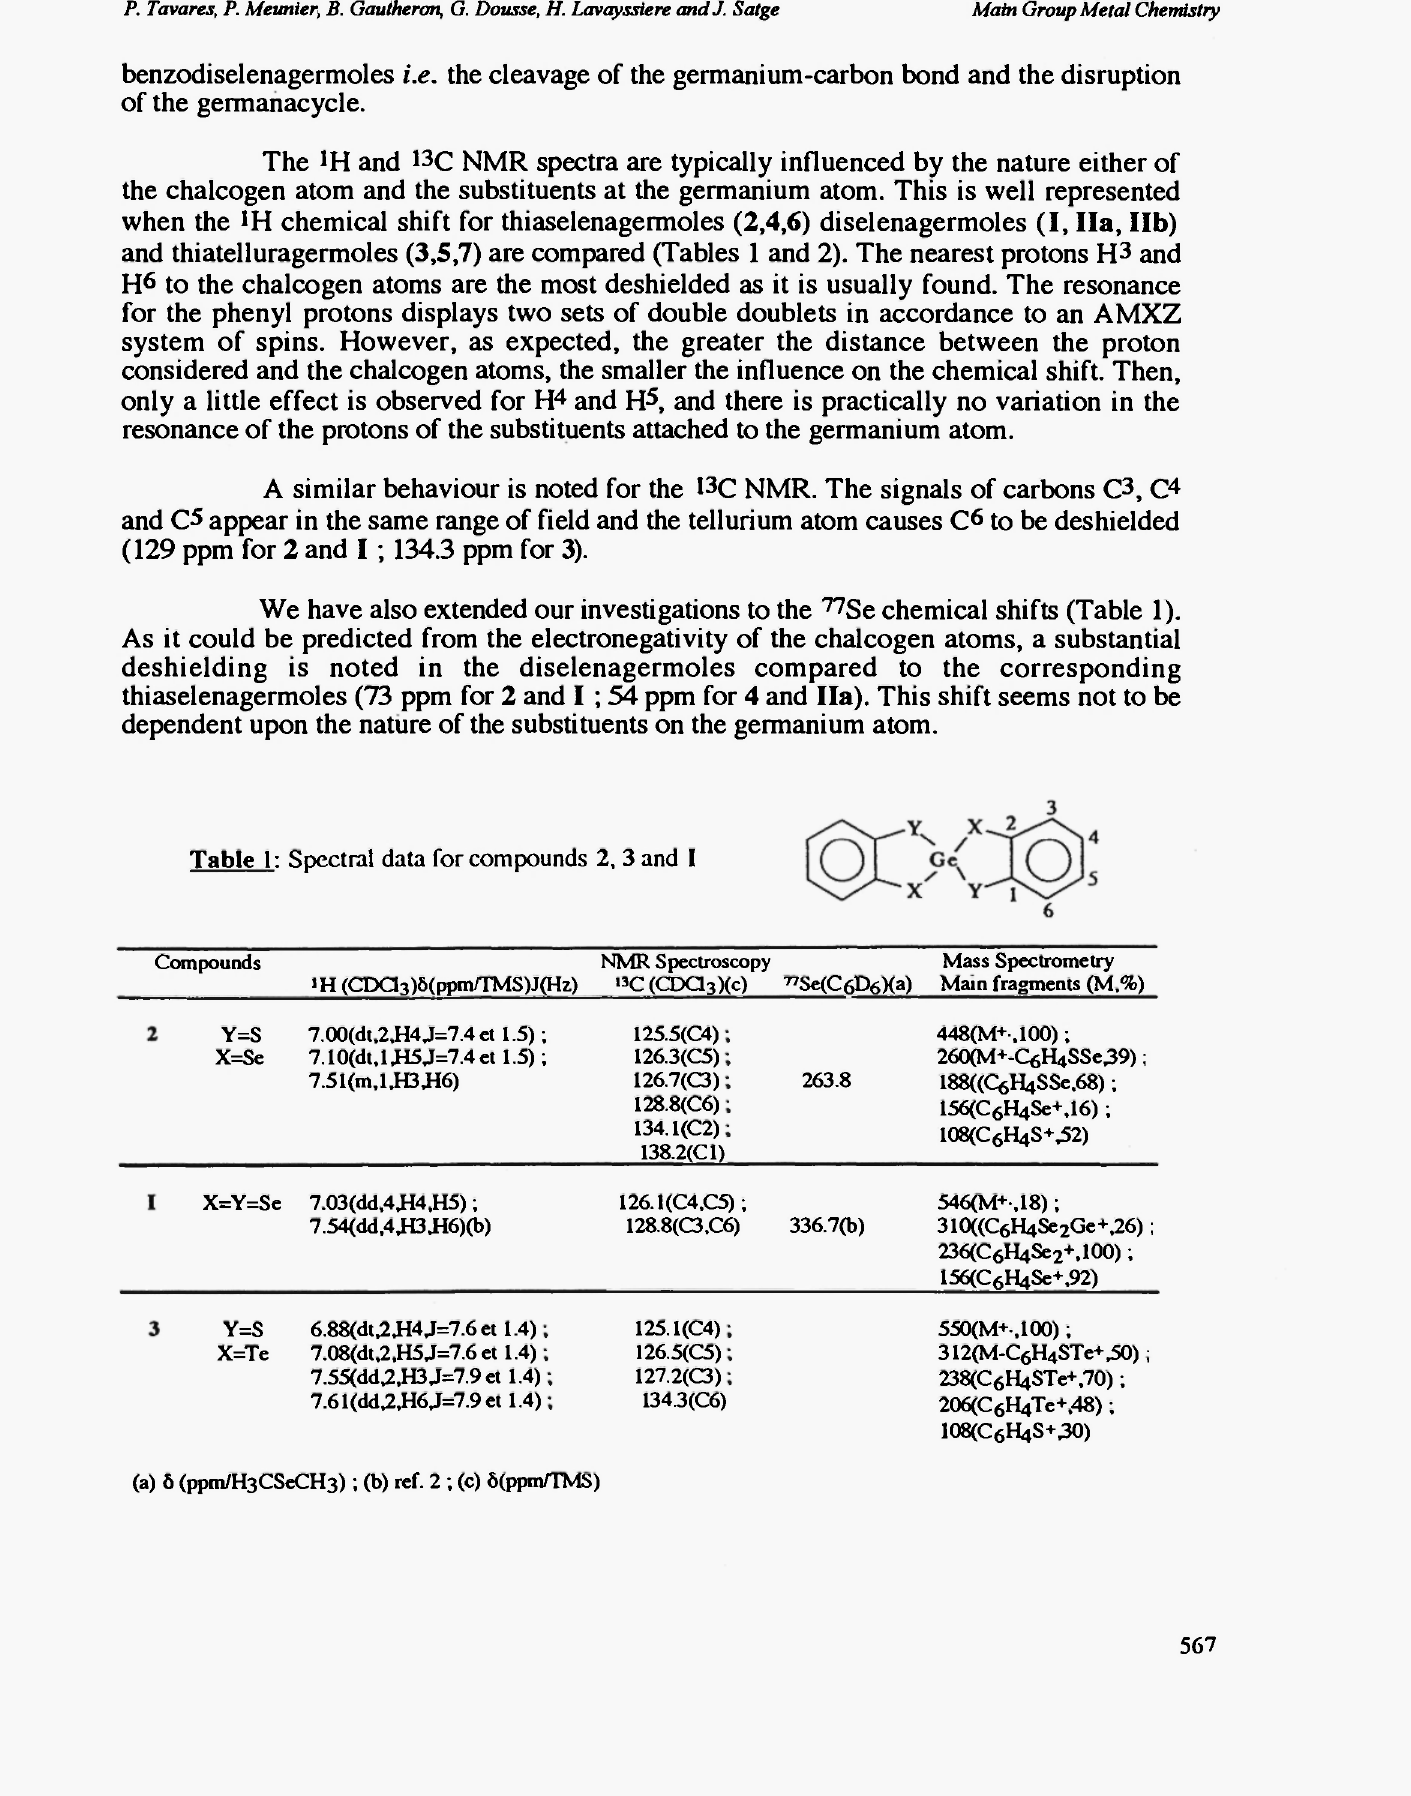
Table 1: Spectral data for compounds 2, 3 and I